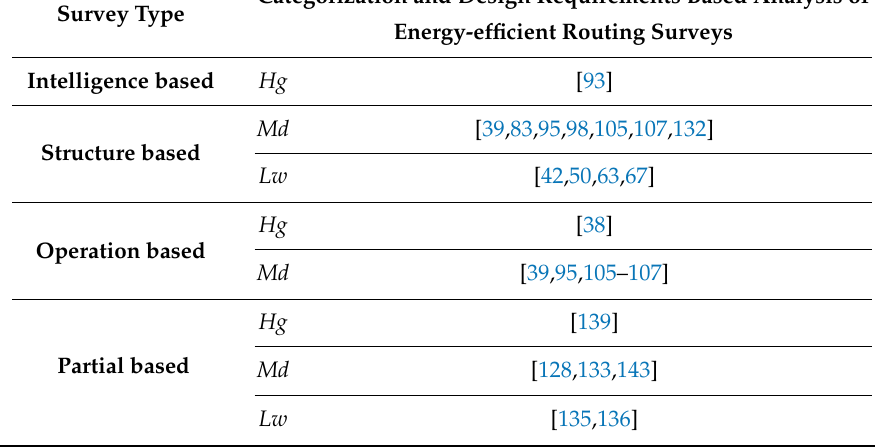
Table 6. Design analysis of energy-efficient routing surveys in